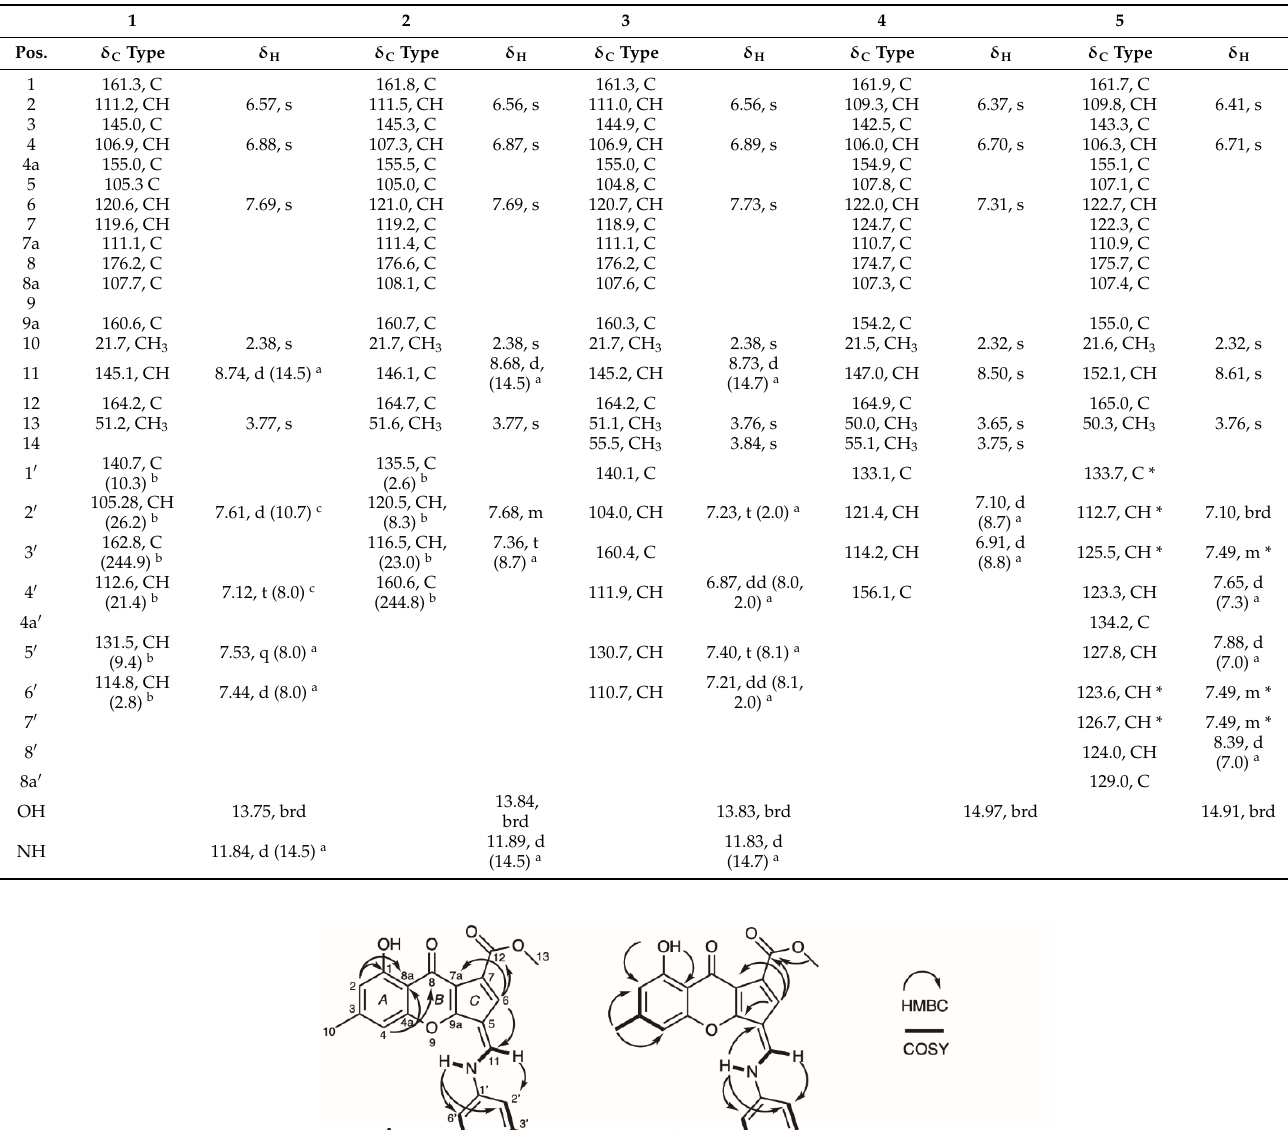
Table 1. 1 H and 13 C NMR spectroscopic data for compounds 1 – 5 (all recorded in DMSO- d 6 ), a J HH in Hz, b J CF , c J HF , * partially assigned from 1D data.